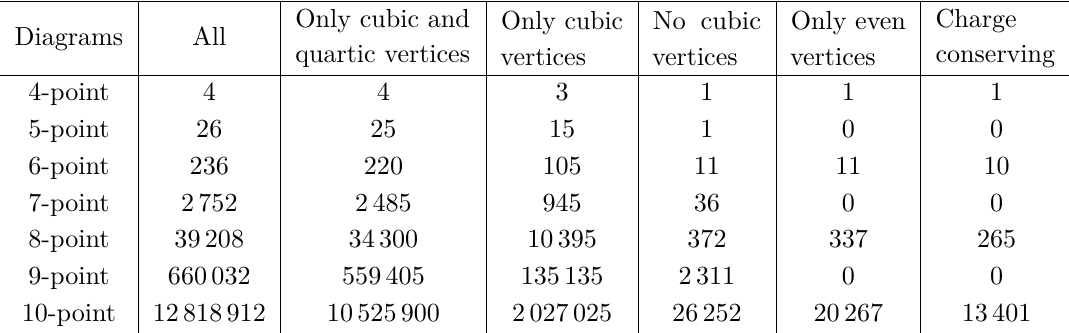
Table 4 . Some benchmark values for the numbers of tree-level Feynman diagrams with up to ten participating particles. The second column displays the total number of diagrams without any restrictions on the interaction vertices. The notation for the other columns is largely self-explanatory. “Even vertices” are vertices with even valency. “Charge-conserving” diagrams are oriented diagrams with only even vertices such that the numbers of legs entering and leaving each vertex are